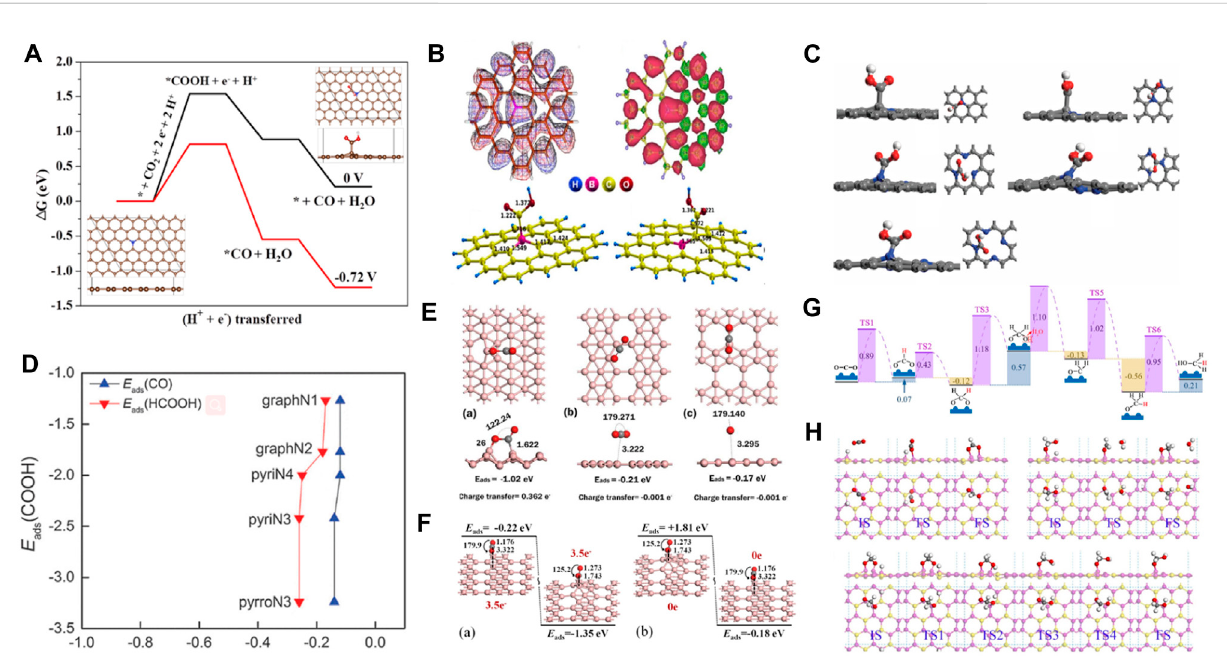
FIGURE 6 (A) The calculated free energy diagram for CO 2 RR to CO on NG-1000 catalyst at 0 V and − 0.72 V vs. RHE. (Figure used with permission from Gu et al., 2021). (B) Electron con fi guration of C 41 BH 16 and adsorption con fi guration of *COOH on different sites. (Figure used with permission from Phani et al., 2013). (C) Structure of COOH species on N-doped graphene. (D) The correlation of the adsorption energies of the intermediate species on various N-doped graphenes. (Figure used with permission from Cai et al., 2016). (E) The adsorption energy and charge transfer (e − ) in the most stable con fi gurationofCO 2 adsorptiononborophene, β 12 and χ 3 boronsheets( fi gureusedwithpermissionfromSmithetal.,2019). (F) EnergychangeofCO 2 on borophene by injection and removal of 3.5 extra electrons ( fi gure used with permission from Smith et al., 2017). (G) Free energy diagram for “ Formate ” path and the models of intermediates and the transition states. (H) The initial, transition, and fi nal states of the OCHO*, OCH 2 * and OCH 2 OH* on B 2 S ( fi gure used with permission from Sun et al.,